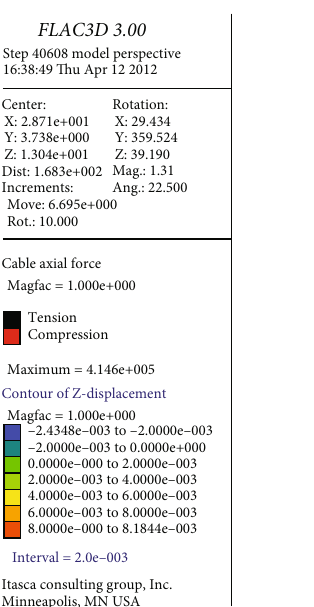
Figure 9: Contour map of vertical displacement of foundation pit